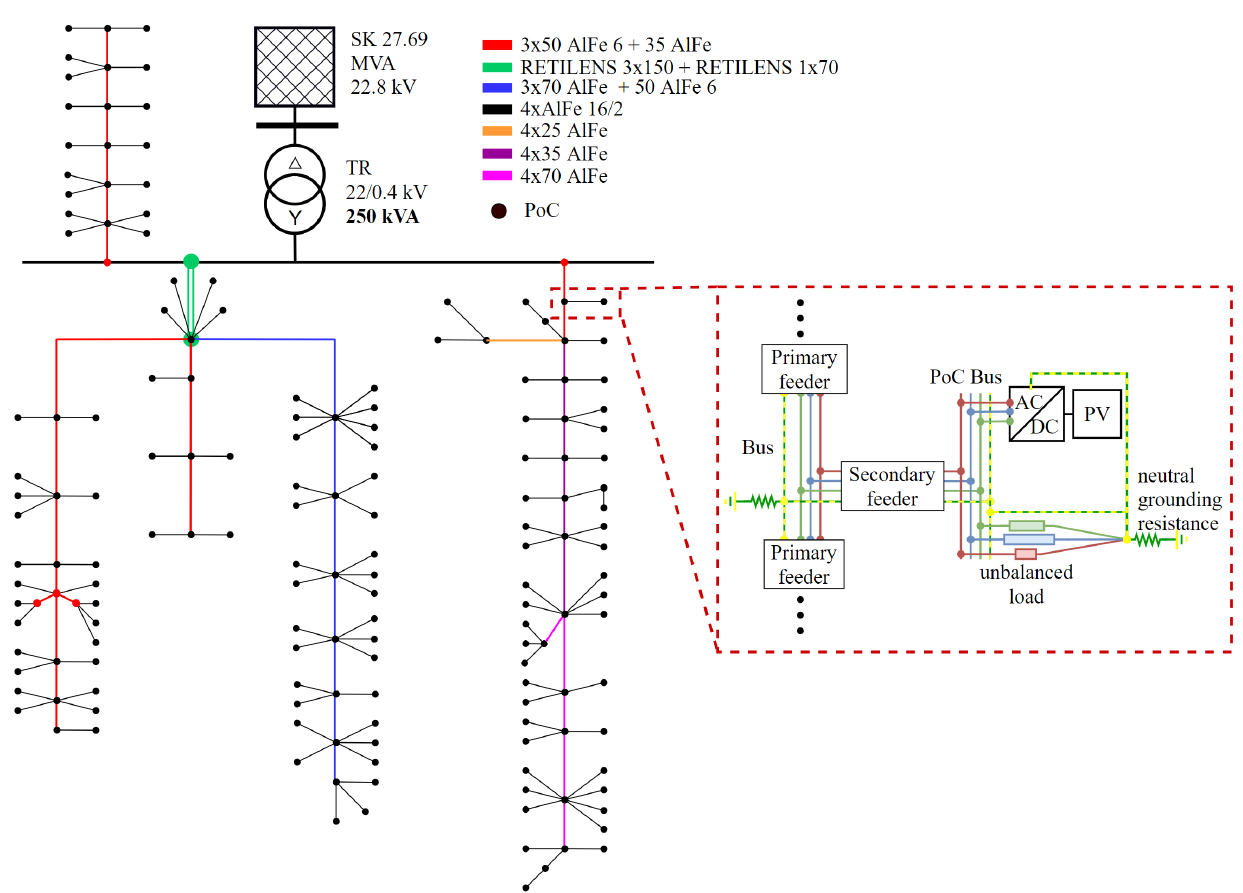
Figure 3. Topology of the analyzed LV network.